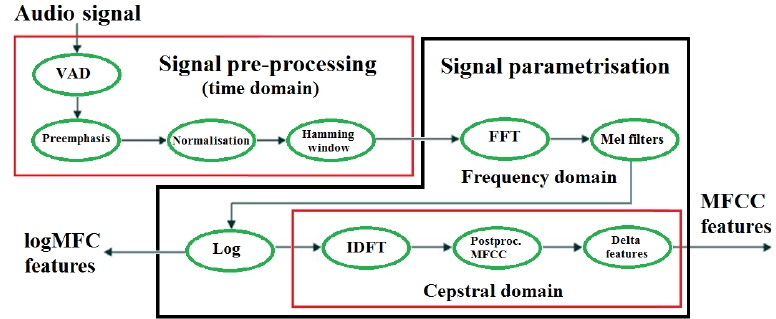
Figure 19. The audio signal parametrisation process, common to the learning and control behaviours of the audio